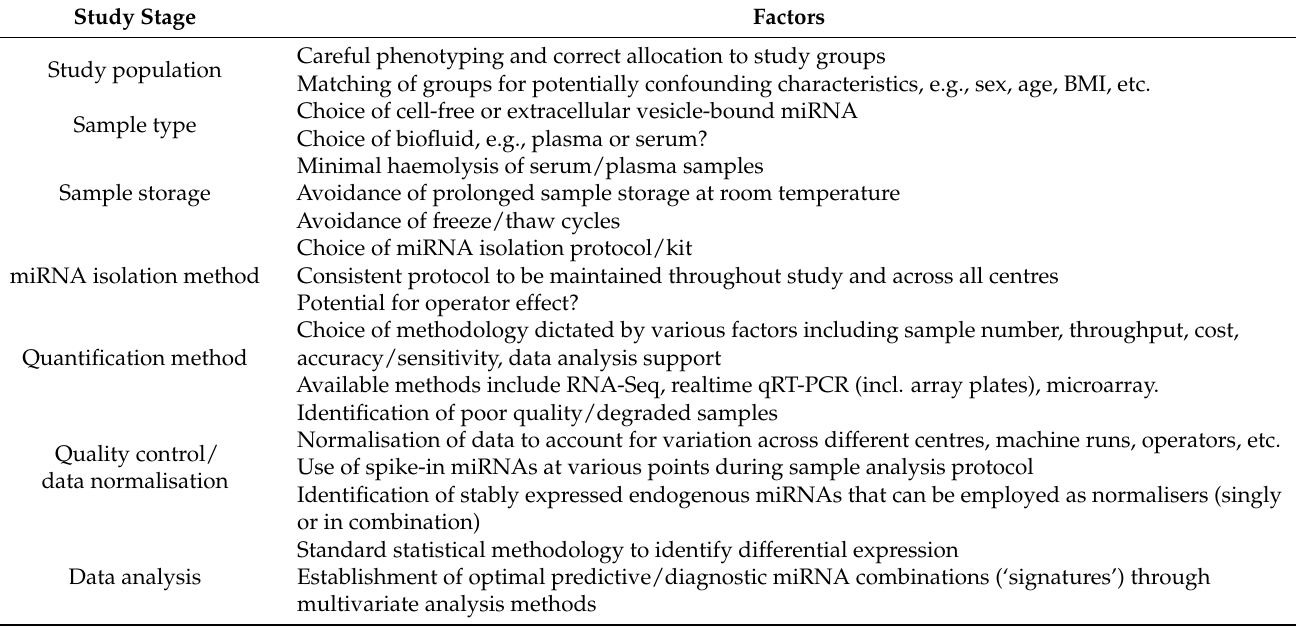
Table 1. Factors to be considered in the design of circulating miRNA analysis study protocols. These have the potential to affect outcome by influencing the number and identities of differentially expressed miRNAs